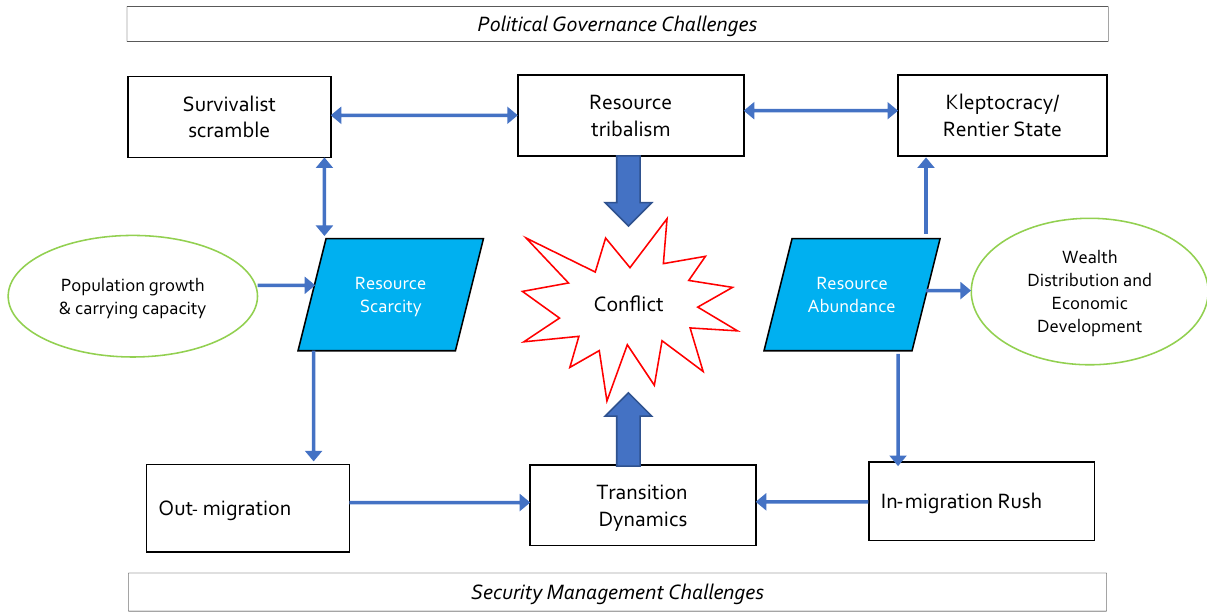
Fig. 1 | Conceptal framework of the interaction between resource scarcity/abundance and migration. Natural resources as a mediator in the link between envir- onmental shocks and